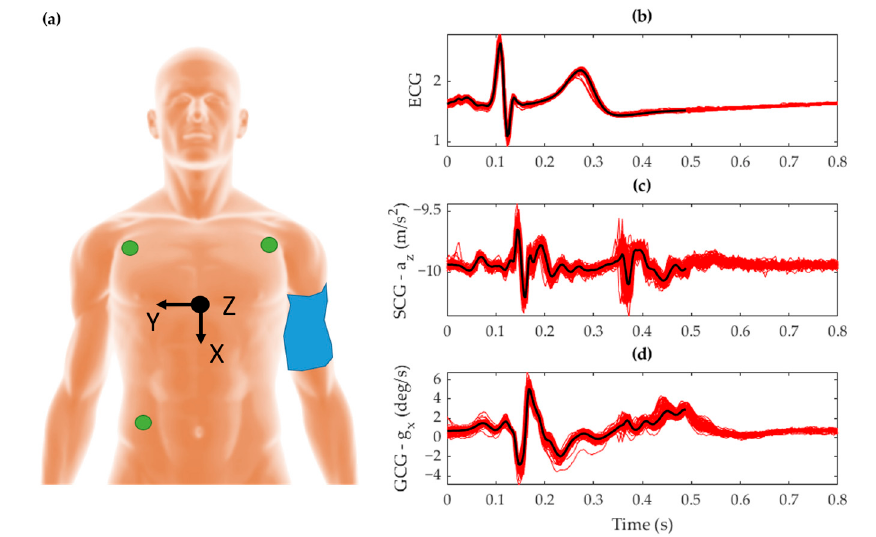
Figure 2. ( a ) Placement of the inertial measurement unit (IMU) sensor (black) with its orientation represented by the Cartesian reference axis, the electrocardiography (ECG) electrodes (green) attached at the extremities of the torso, and the cuff sphygmomanometer (blue) strapped around the upper left arm with the subject lying supine. The corresponding signal morphology is shown for ( b ) ECG voltage, ( c ) seismocardiography (SCG) Z-axis acceleration, and ( d ) gyrocardiography (GCG) X-axis gyration. The plots show ensembled averages (black) of the raw signals (red) that were temporally aligned to the time signature of the R-peak over a window of 100 beats.